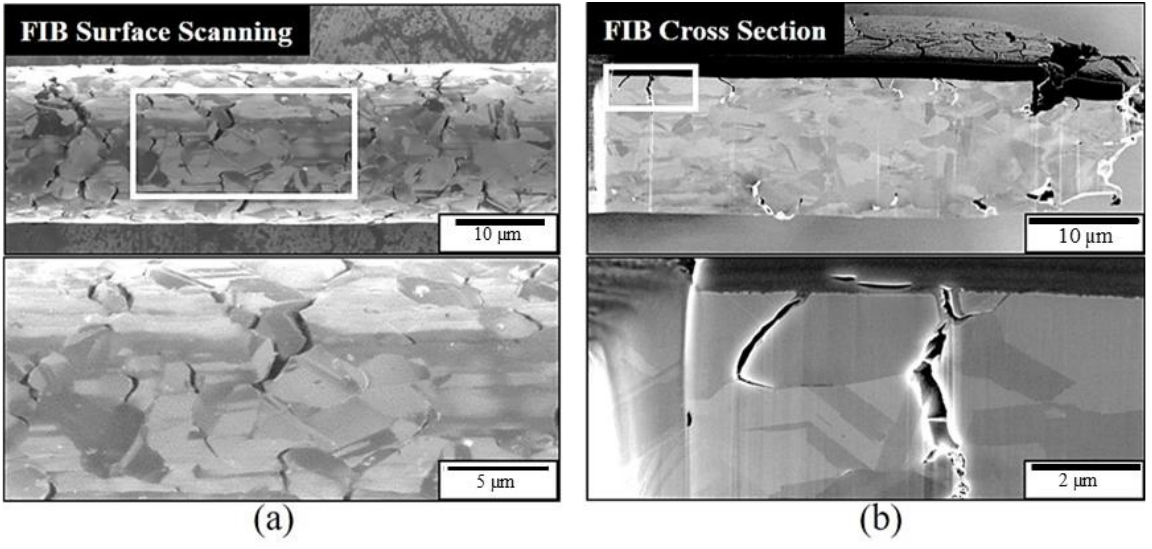
Figure 4. Tensile fracture cross-section of the APAP wire after 4 h of chlorination: ( a ) focus ion beam (FIB) surface scanning, and ( b ) cross-section image.